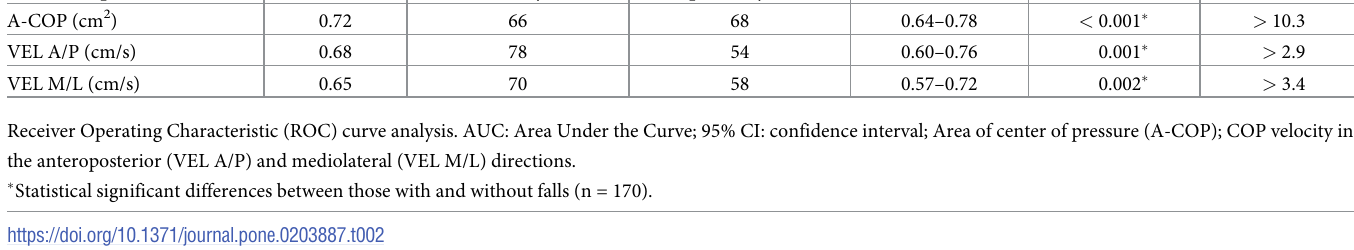
Table 2. Area under curve, sensitivity, specificity for the force platform variables. Force plate